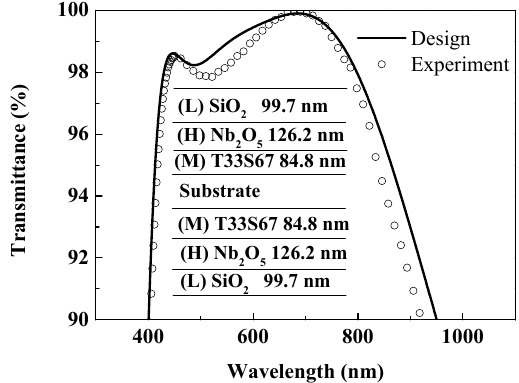
Figure 7. Measured (symbols) and theoretical (line) transmittance spectra of the triple-layer broadband AR coating on both sides of fused quartz substrate. The inset schematic diagram lists the optimized film thickness for each layer of the antireflective (AR) coating. Labels M, H and L for individual layers are from the subscripts for film refractive indices in Equations (1) and (2).